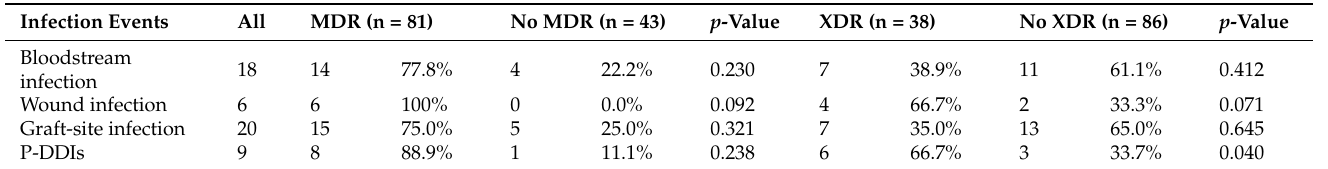
Table 5. Impact of antimicrobial resistance in ESKAPE on early infection-related events after kidney transplantation.